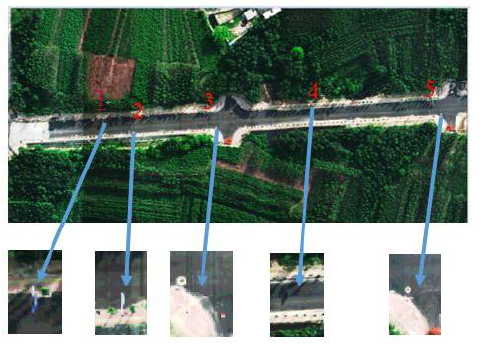
Figure 10. Five feature points of CCD images